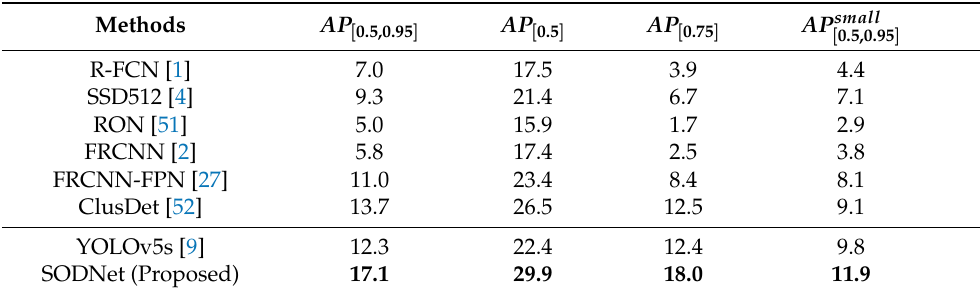
Table 5. Performance comparison with the baselines and proposed method on the UAVDT test dataset. The best results are marked in